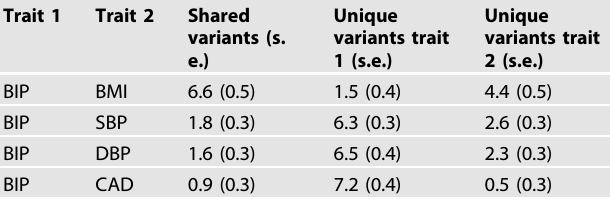
Table 1. The results of MiXeR analysis for BIP and CVD